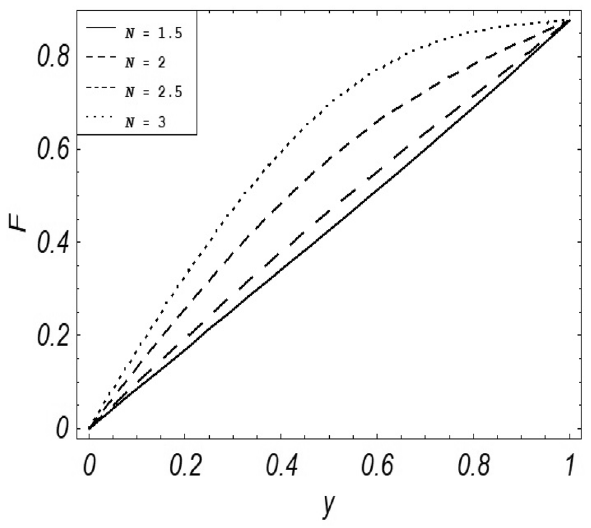
Figure 2. Evolution of F with various values of N if t = 1 ; Gr = 2.5 ; K 1 = 0.5 ; η = 2 ; M = 0.2 ; � = 0.5 ; Re = 1 ; α = 0.1 ; ω = 0.5 ; ε = 0.001